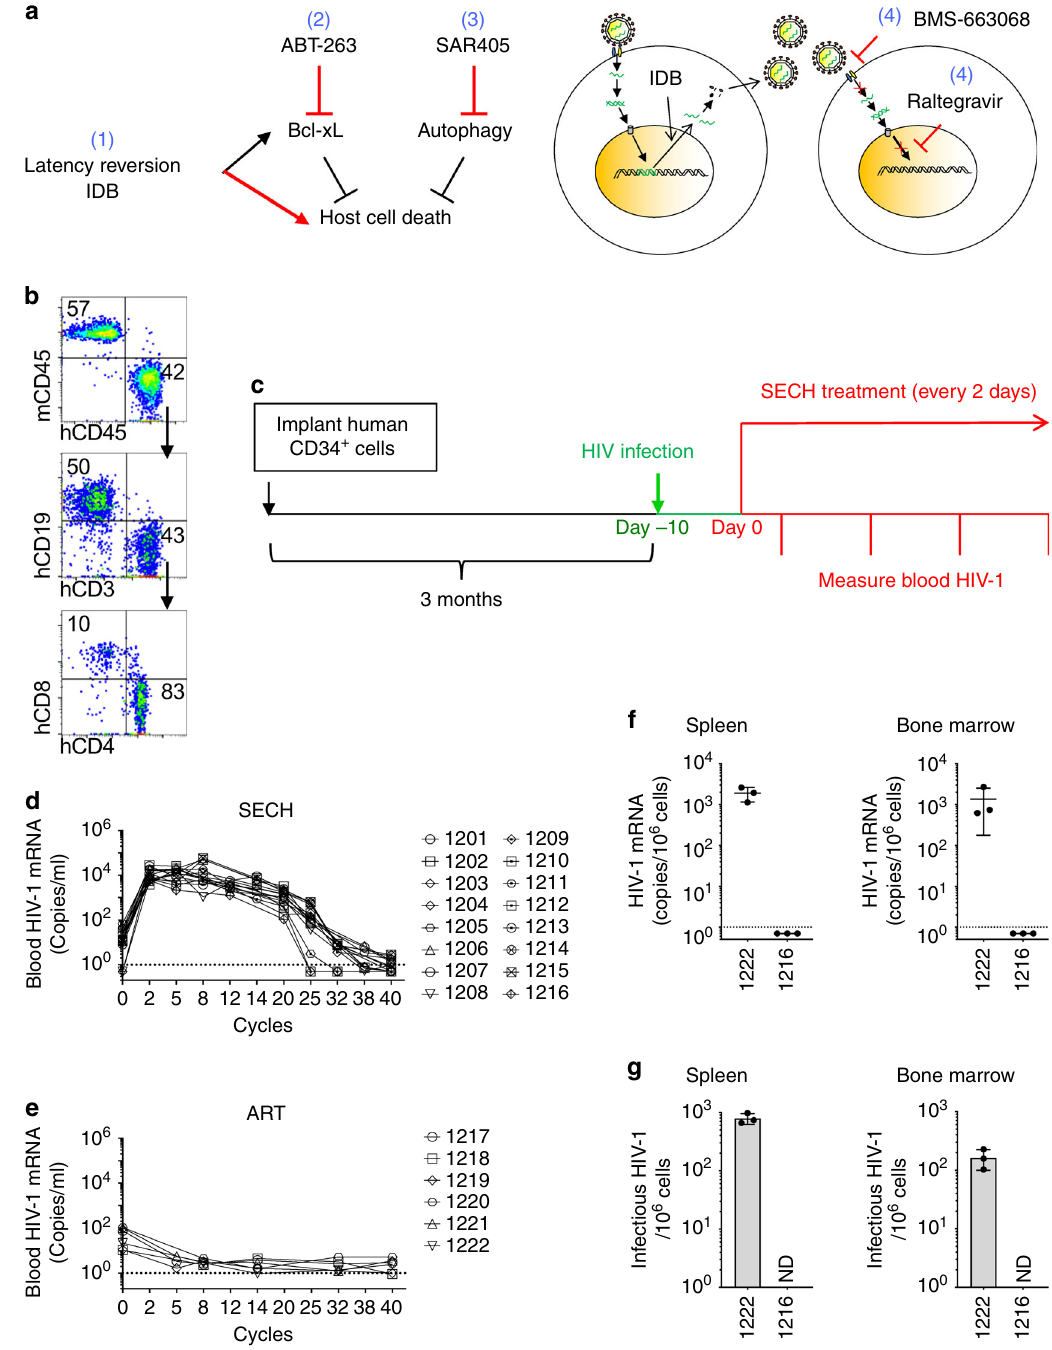
Fig. 3 Treatment of HIV-1 infections in Hu-HSC mice by SECH. a The SECH regimen includes: (1) latency reversion; (2) induction of cell death; (3) inhibition of autophagy; and (4) blocking of new infections with inhibitors for HIV-1 attachment and integration. b An example of fl ow cytometry analyses of human cells in the peripheral blood of NSG-SGM3 mice 3 months after reconstitution with human CD34 + stem cells. Cell negative for mouse CD45 (mCD45) and positive for human CD45 (hCD45) were gated to analyze CD19 + human B cells, CD3 + CD4 + , and CD3 + CD8 + human T cells. c Three months after reconstitution with human CD34 + stem cells, one set of HIV-1-infected Hu-HSC mice (Supplementary Table 1) were infected with HIV-1 (AD8 strain, 1000 pfu/mouse) intraperitoneally. Ten days after HIV-1 infections, the mice were used for treatments by ART or SECH. d , e RNA from the whole blood (including plasma and cells) was extracted to measure HIV-1 mRNA in mice treated by SECH e or ART f for 40 cycles. The dash line indicates detection limit. f HIV-1 mRNA in the spleen and bone marrow of mice treated by SECH or ART was determined by RT-PCR. Data are presented as mean ± SD ( n = 3 technical replicates). ND, not detectable. g Infectious HIV-1 in the spleen and bone marrow of mice treated by SECH or ART was measured by TZA assays. Data are presented as mean ± SD ( n = 3 technical replicates). Source data are provided as a Source Data fi